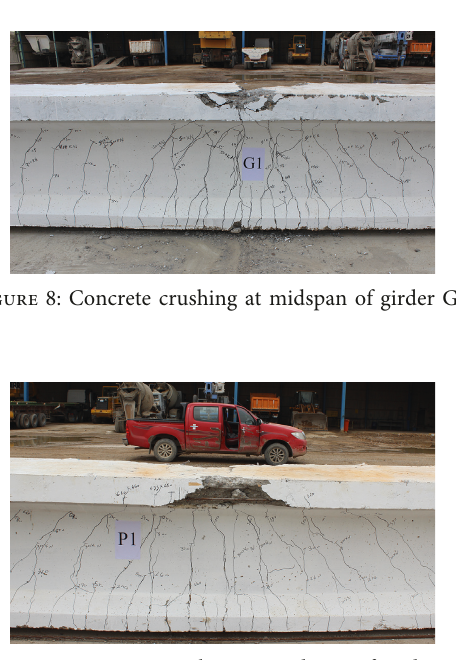
Figure 9: Concrete crushing at midspan of girder